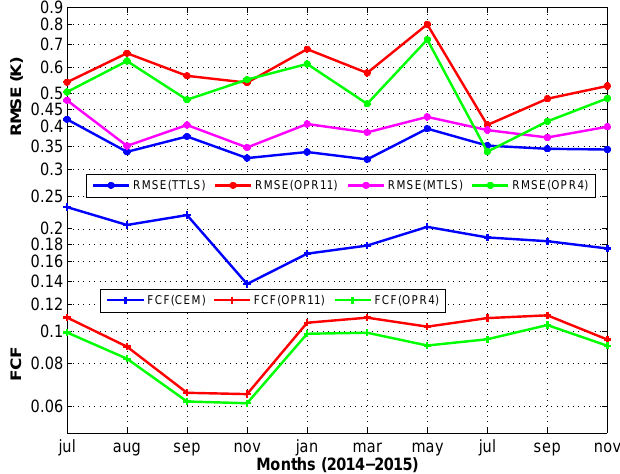
Figure 7. Comparative monthly RMSE statistics for TTLS, MTLS, OPR4 and OPR11, and data coverage for CEM, OPR4 at MQL = 5 and OPR11 at MQL =